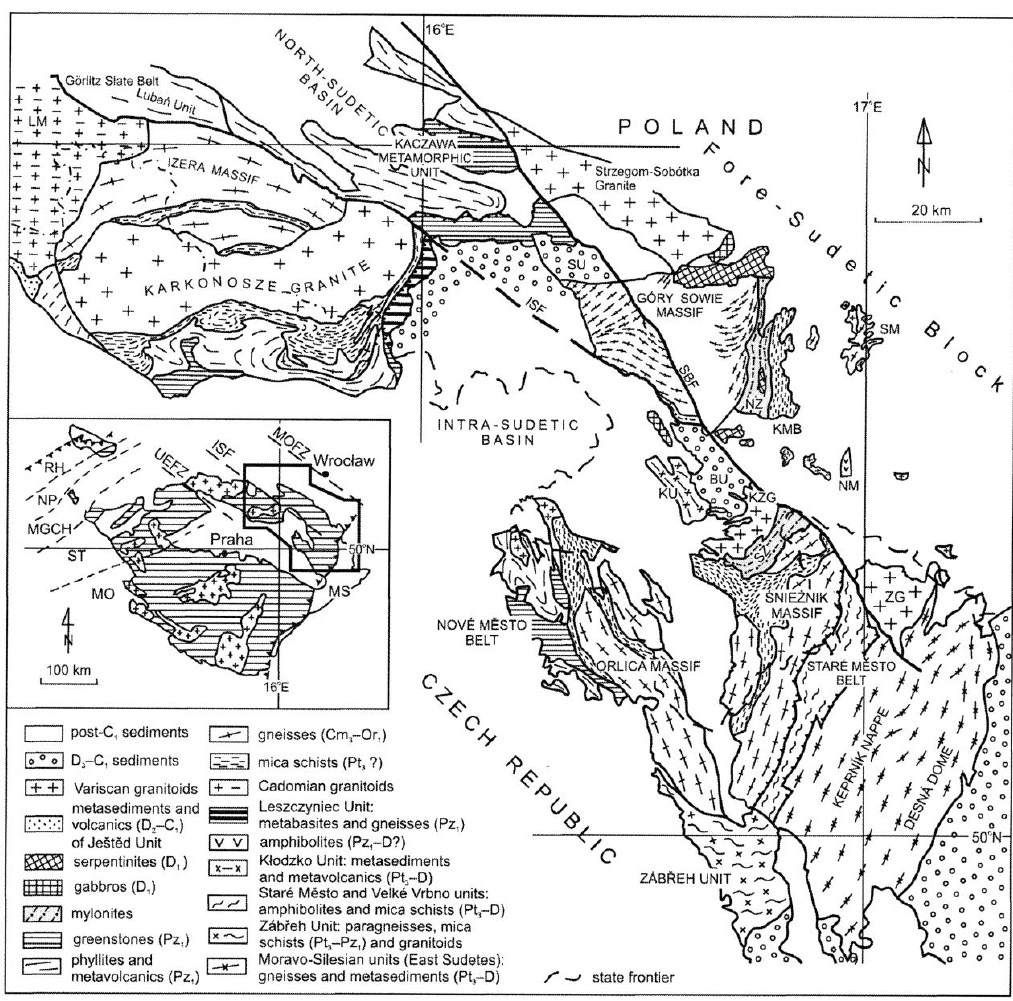
Fig. 1. Geological sketch map of the Sudetes (after Aleksandrowski et al., 1997). Explanations: BU – Bardo Sedimentary Unit, ISF – Intra-Sudetic Fault, KMB – Kamieniec Metamorphic Belt, KU – Kłodzko Metamorphic Unit, KZG – Kłodzko-Złoty Stok Granite, LM – Lusatian Massif, MGCH – Mid-German Crystalline High, MO – Moldanubian Zone, MOFZ – Middle Odra Fault Zone, MS – Moravo- Silesian Zone, NM – Nied´zwied´z Massif, NP – Northern Phyllite Zone, NZ – Niemcza Shear Zone, RH – Rhenohercynian Zone, SU – ´Swiebodzice Sedimentary Unit, SBF – Sudetic Boundary Fault, SM – Strzelin Massif, ST – Saxothuringian Zone, SZ – Skrzynka Shear Zone, UEFZ – Upper Elbe Fault Zone, ZG – Žulová Granite. Springs and intakes examined by the author were located within: Izera Massif, Karkonosze Granite, Intra-Sudetic Basin, Strzegom-Sobótka Granite, Kamieniec Metamorphic Belt, ´Snie˙znik Massif, Orlica Massif, Kaczawa Metamorphic Unit, Góry Sowie